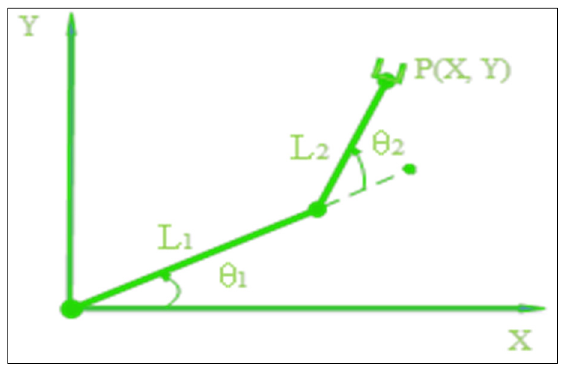
Fig. 1. Two degrees of freedom manipulator